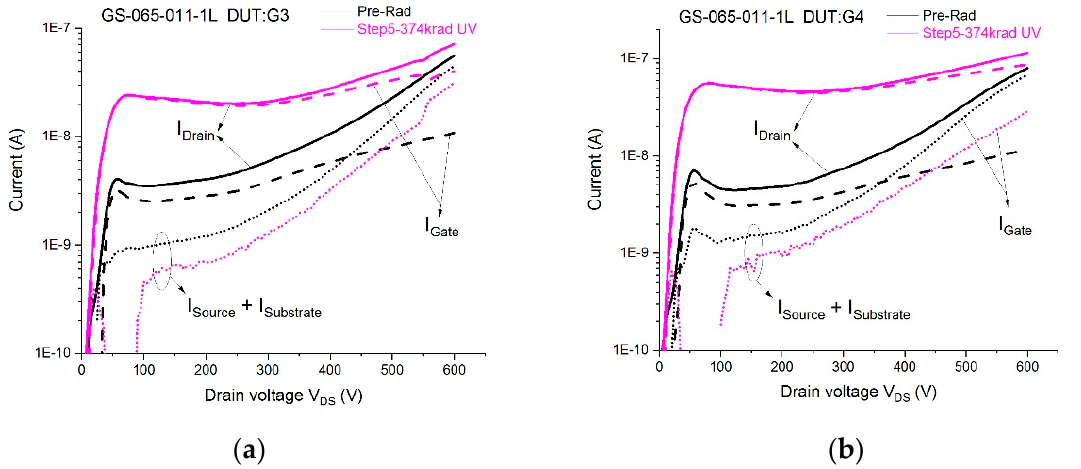
Figure 5. The leakage currents versus drain voltages in the off state (V GS = 0 V) before (black lines) and after (magenta lines) gamma radiation with a total ionising dose of 374 krad(SiO 2 ) which were stressed during irradiation with V DS = 500 V and V GS = 0 at a base temperature of 133 °C. ( a ) Device G3 ( b ) Device G4.